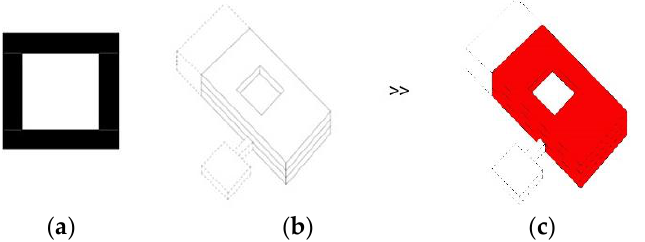
Figure 8. Atrial layout. ( a ) Planimetric scheme; ( b ) Axonometric scheme; ( c ) Axonometric scheme with the minimum area that must be dedicated to the infectious disease section indicated red.